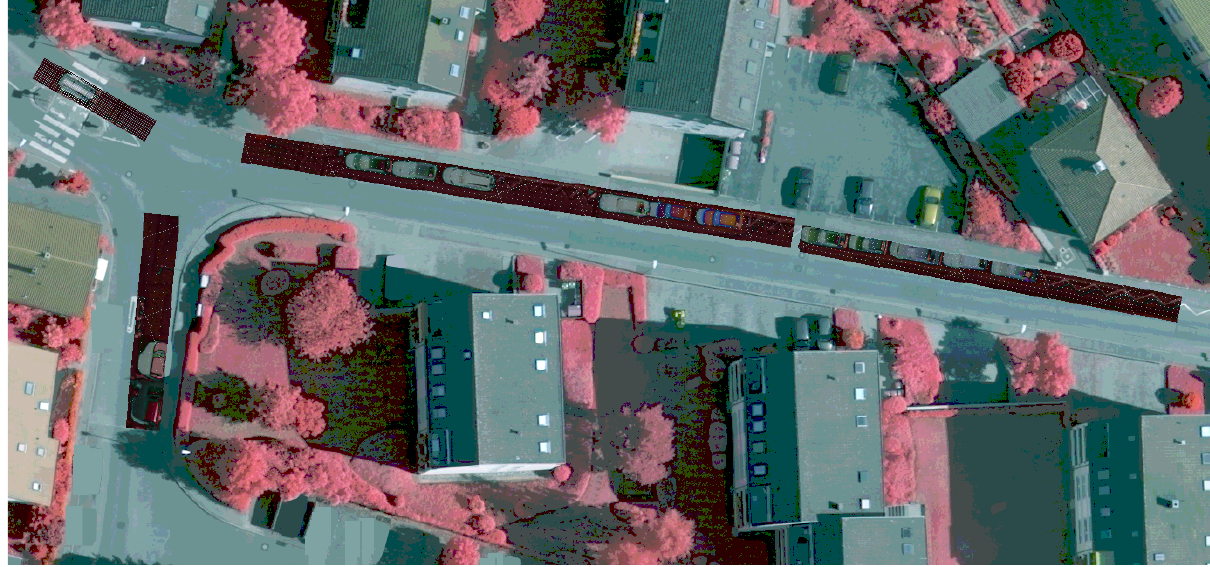
Figure 5. This is the result after registering the target image on the source image. Vehicle on the road can be recognised